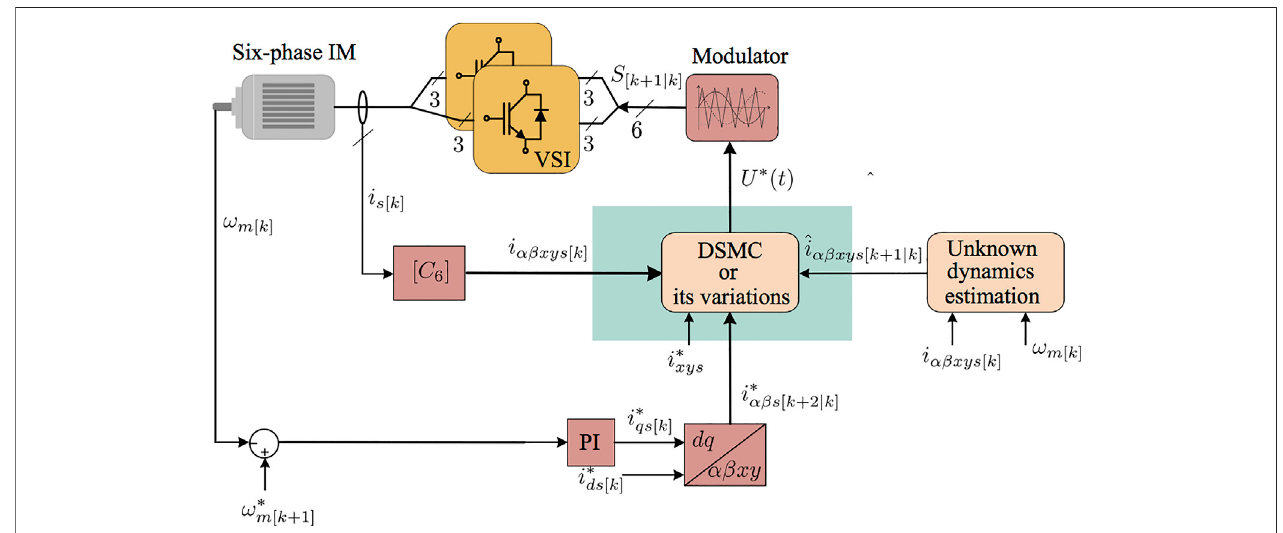
FIGURE 11 | Classic SMC scheme for asymmetrical six-phase IM fed by two Voltage Source Inverters (VSI).